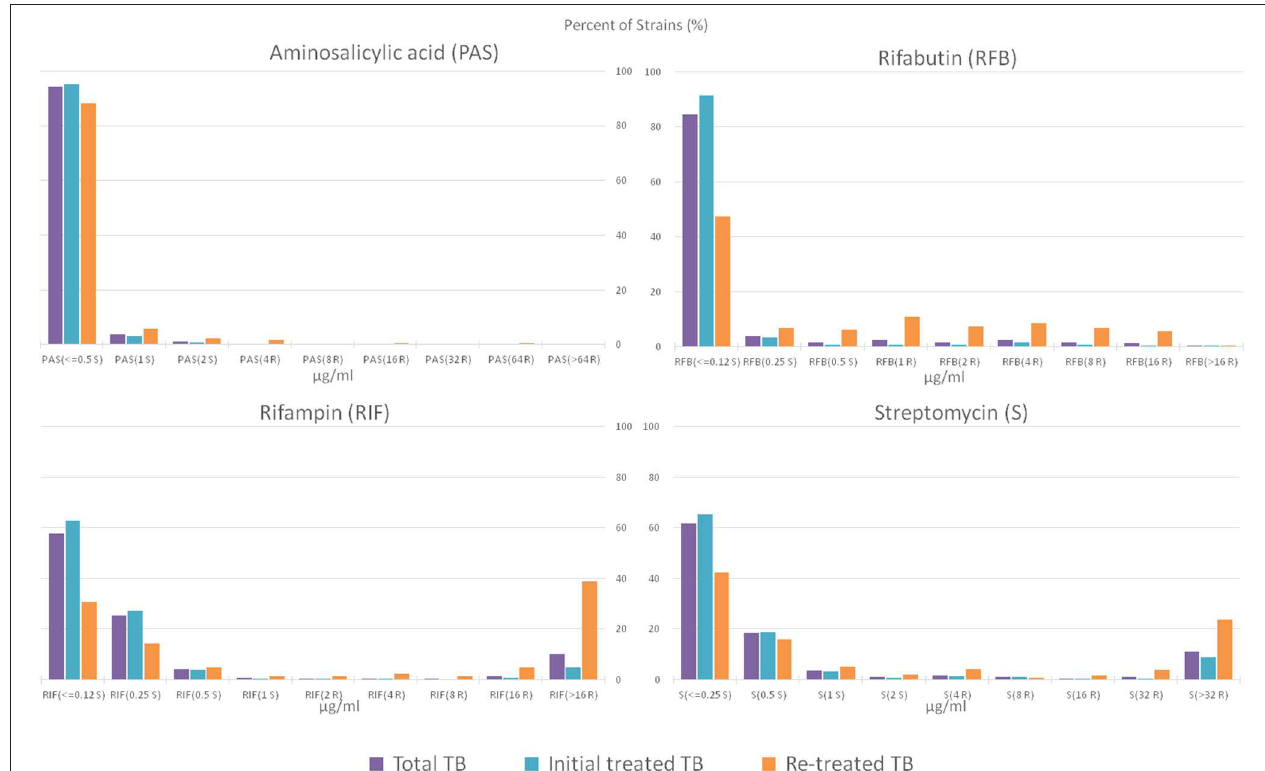
FIGURE 3 | Percentage distribution plot of MICs of amikacin, cycloserine, ethionamide, ethambutol, isoniazid, kanamycin, moxifloxacin, ofloxacin, aminosalicylic acid, rifabutin, rifampin and streptomycin, against MTB isolates isolated from total TB, initial treated TB and re-treated TB. S and R after the MIC concentration represent sensitivity and resistance,